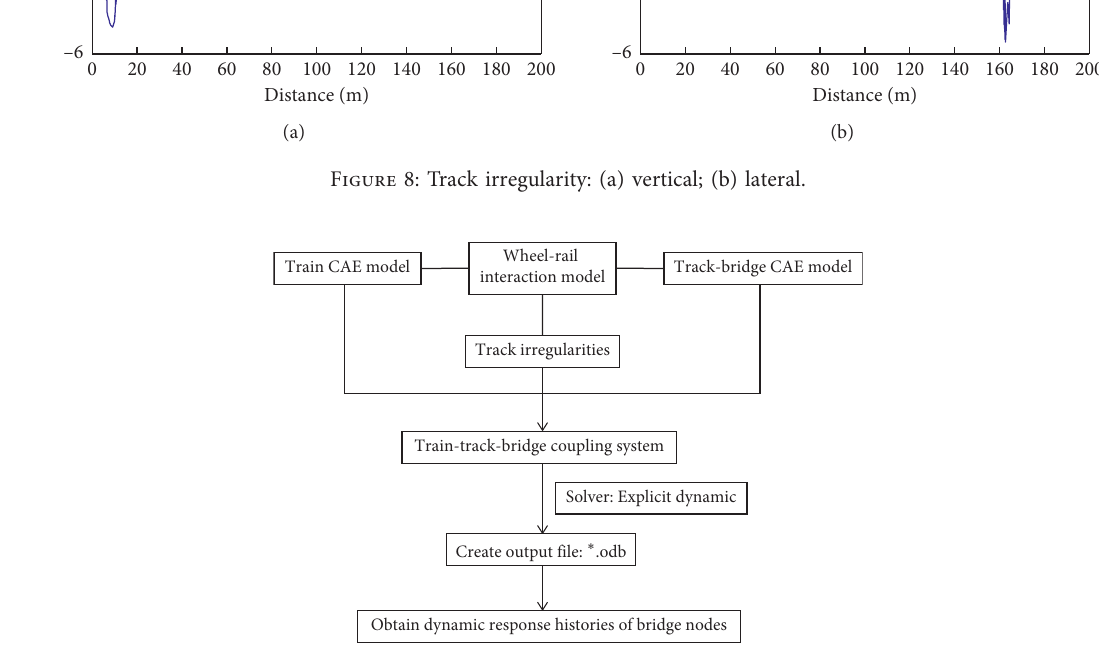
Figure 9: Solution procedures for DR of the bridge.